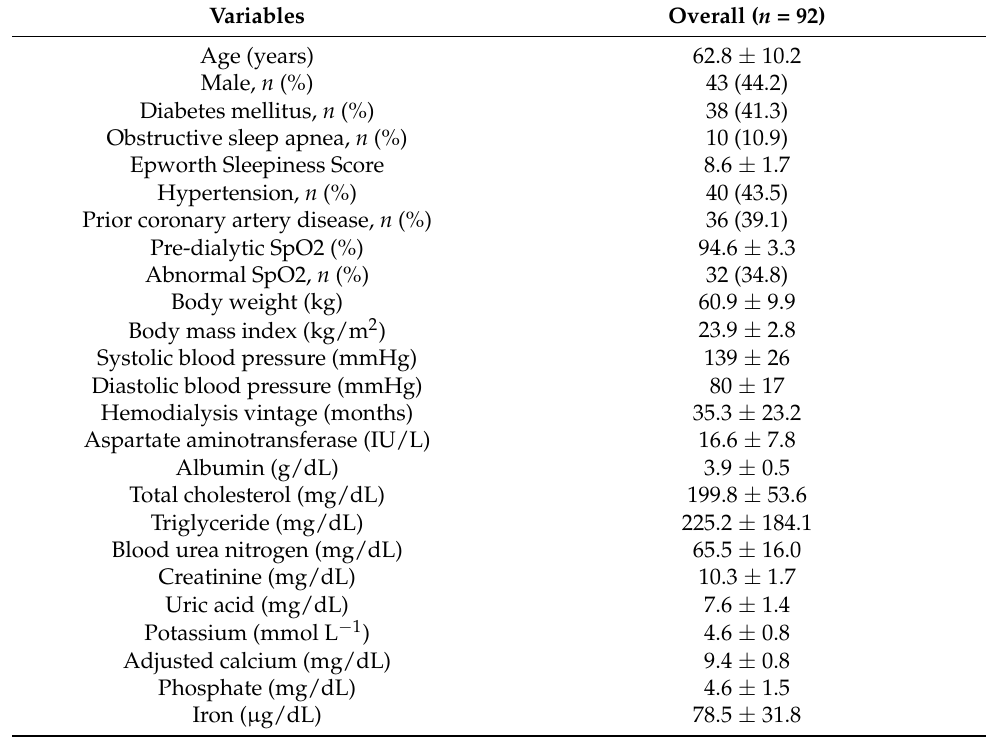
Table 1. Baseline bioclinical characteristics and laboratory features of the whole study